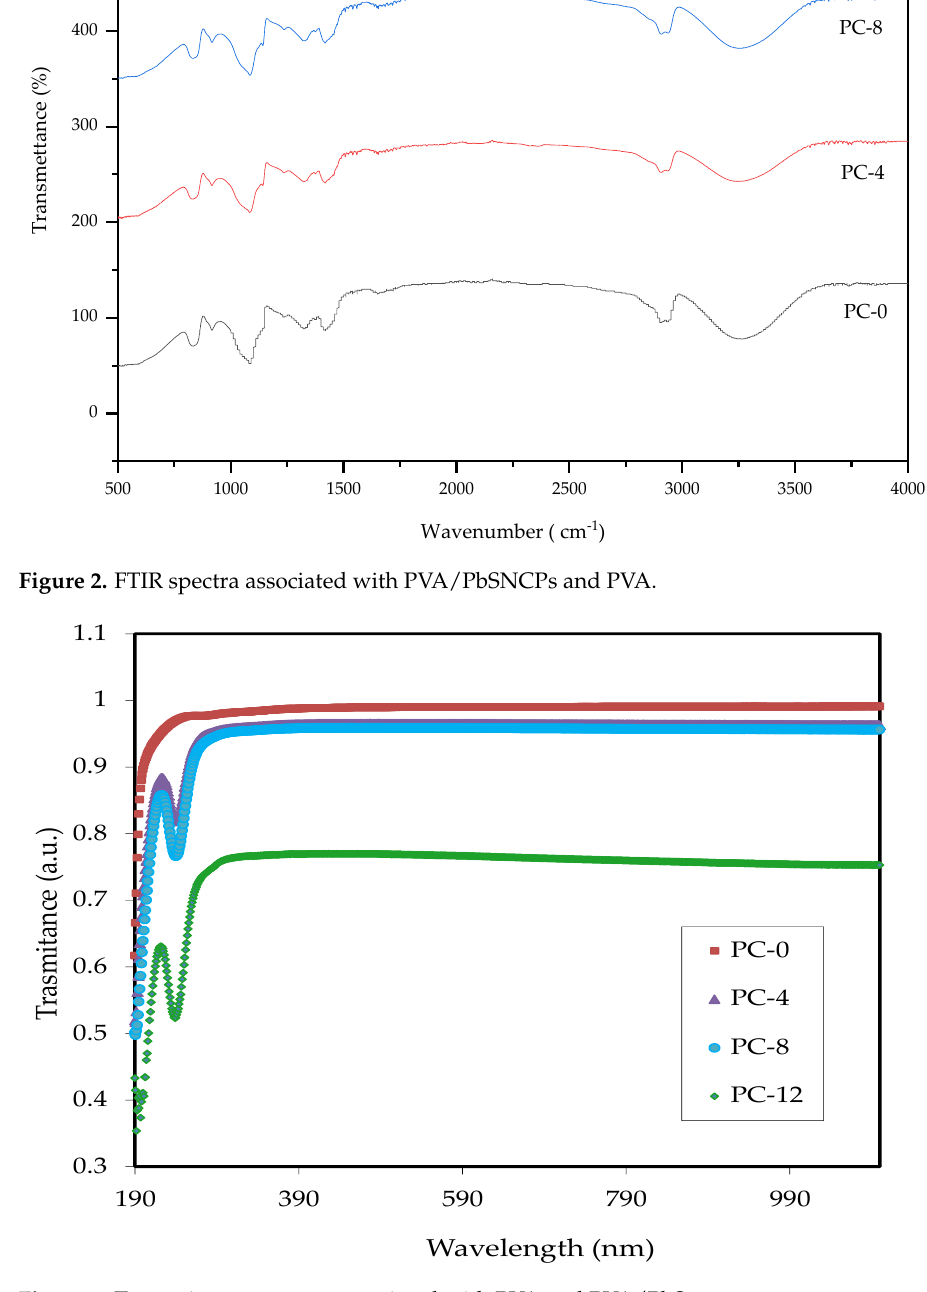
Figure 3. Transmittance spectra associated with PVA and PVA/PbS.